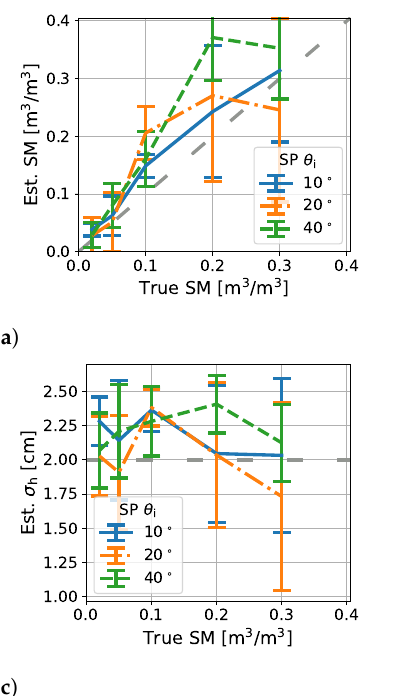
Figure 9. Soil moisture retrievals from simulated DDM; σ h = 2cm and SNR = 20dB, using the first scheme. The error bars represent one standard deviation from the mean, and the gray lines represent perfect retrievals. ( a ) Grassland land cover. ( b ) Mixed forest land cover. ( c ) Grassland land cover. ( d ) Mixed forest land